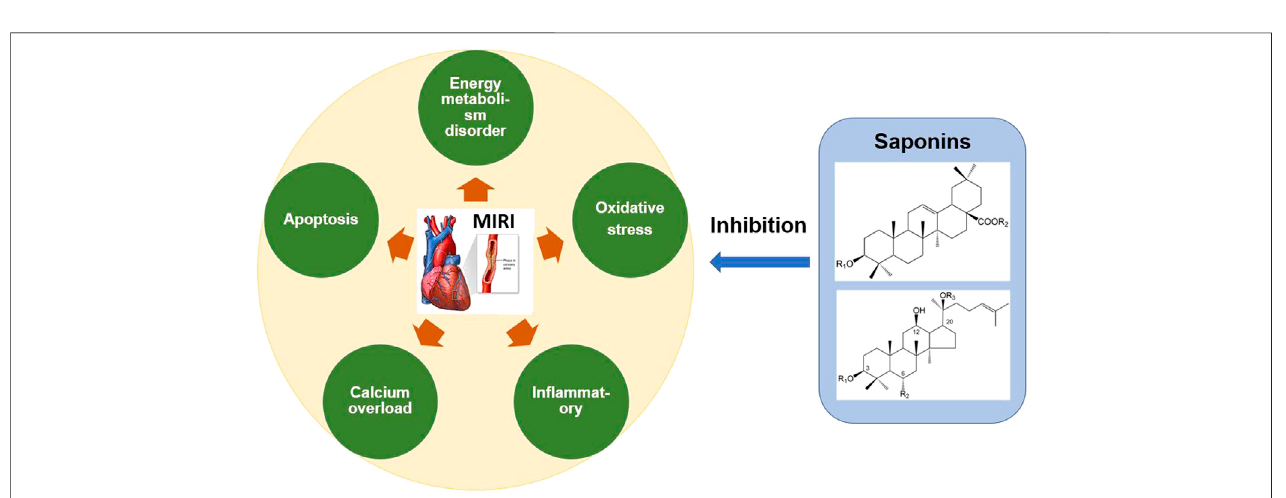
FIGURE 4 | Mechanism of anti-MIRI of saponins in Chinese Herbal Medicine. The saponins in Panax ginseng , Panax notoginseng , Aralia , Astragalus and other Chinese herbal medicine can signi fi cantly alleviate MIRI. These saponins inhibit oxidative stress, energy metabolism disorder, calcium overload, in fl ammation and apoptosis, and thus exert the cardioprotective effect.